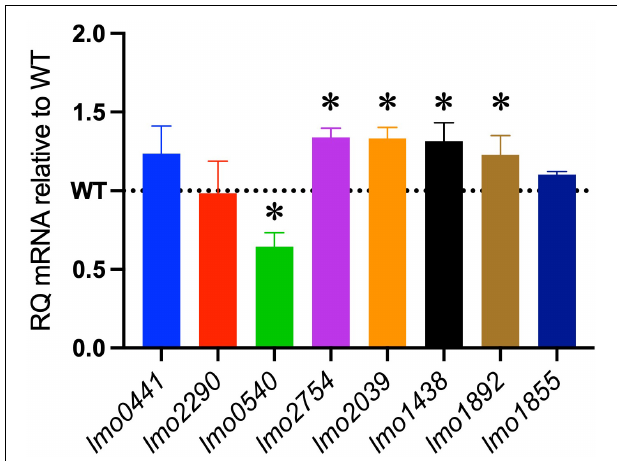
FIGURE 7 | Impact of the (cid:49) cspABD mutation on mRNA abundance of selected penicillin-binding protein (PBP) genes. Bar graphs showing the relative quantities of PBP gene mRNAs in EGDe_ (cid:49) cspABD relative to the WT strain whose level is denoted by a dotted line in stationary-phase cells cultivated in BHI for 16 h at 37 ◦ C and 150 rpm. RT-qPCR was performed on mRNA samples isolated from cells cultivated for 16 h at 37 ◦ C and 150 rpm in BHI. 16S rRNA was used for mRNA normalization. ∗ P < 0.05, significant differences in mRNA levels between the WT and (cid:49) cspABD strains identified using the t -test for comparison of independent